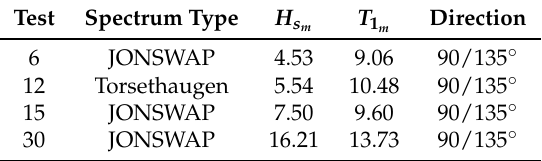
Table 2. Expected properties of the measured sea conditions (see